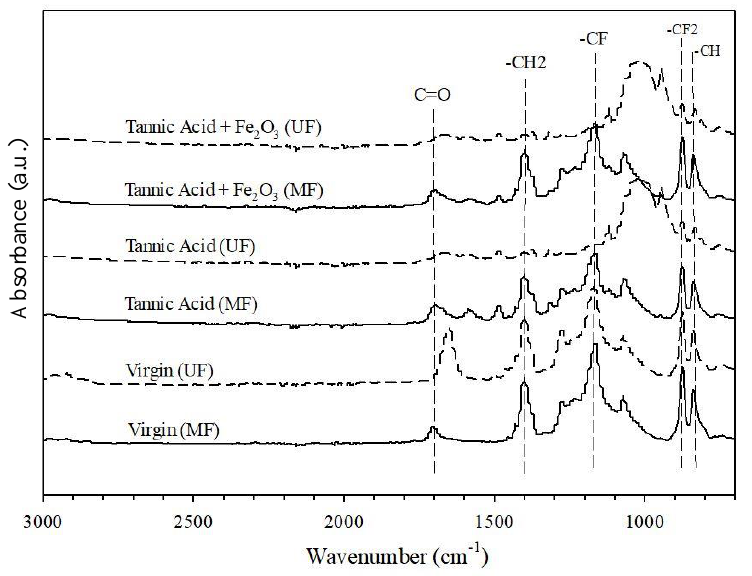
Figure 3. FTIR spectra of virgin and fouled UF and MF membranes filtrated with TA and TA + Fe 2 O 3 feed waters.